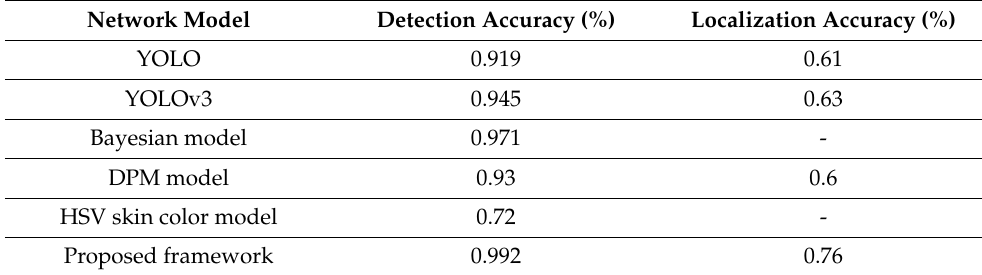
Figure 11. Confusion matrix of NUS-II dataset. Table 1. Comparison of detection accuracy and localization